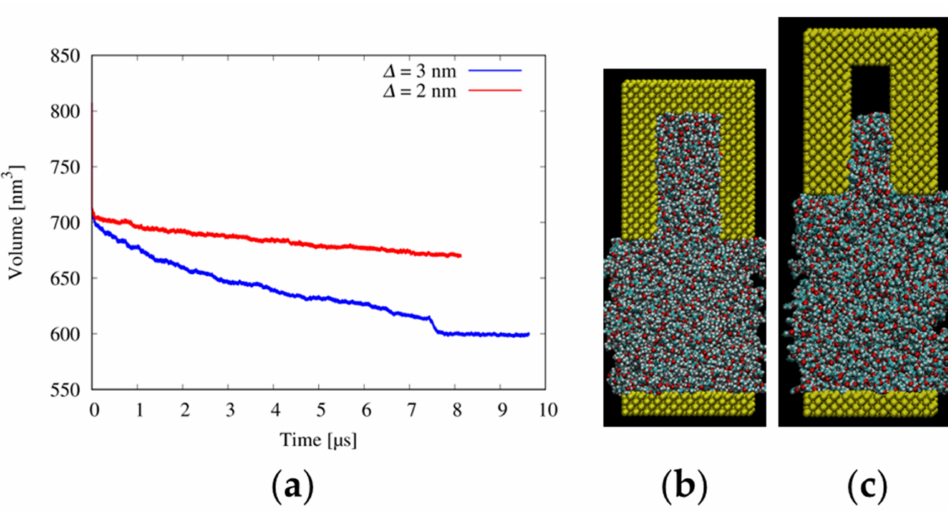
Figure 3. Filling simulation of resist IV. ( a ) Change in the system volume as a function of the simulation time, and snapshots of the systems at the end of the simulations with trench widths of ( b ) 3 and ( c ) 2 nm, respectively. In the snapshots, the molds are made from silicon atoms, and the substrates are illustrated using yellow spheres.